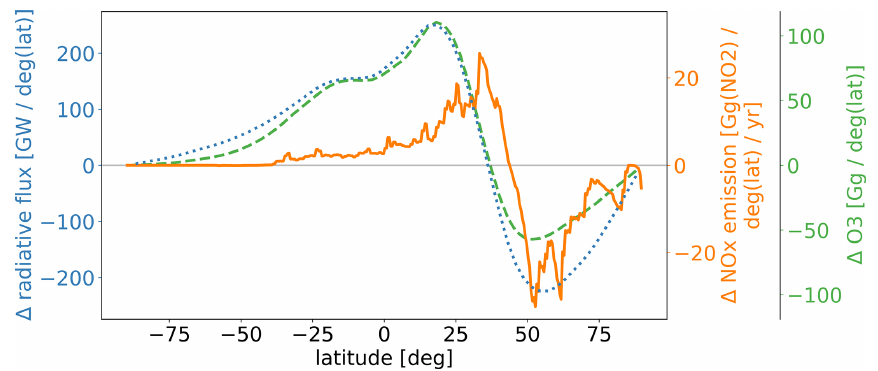
Figure 2. Differences (CMIP5 – CMIP6) in NO x emissions (solid orange line), O 3 burden (dashed green line), and radiative flux (dotted blue line) from two simulations with an identical total amount of aviation emissions, but different latitudinal distributions, as a function of